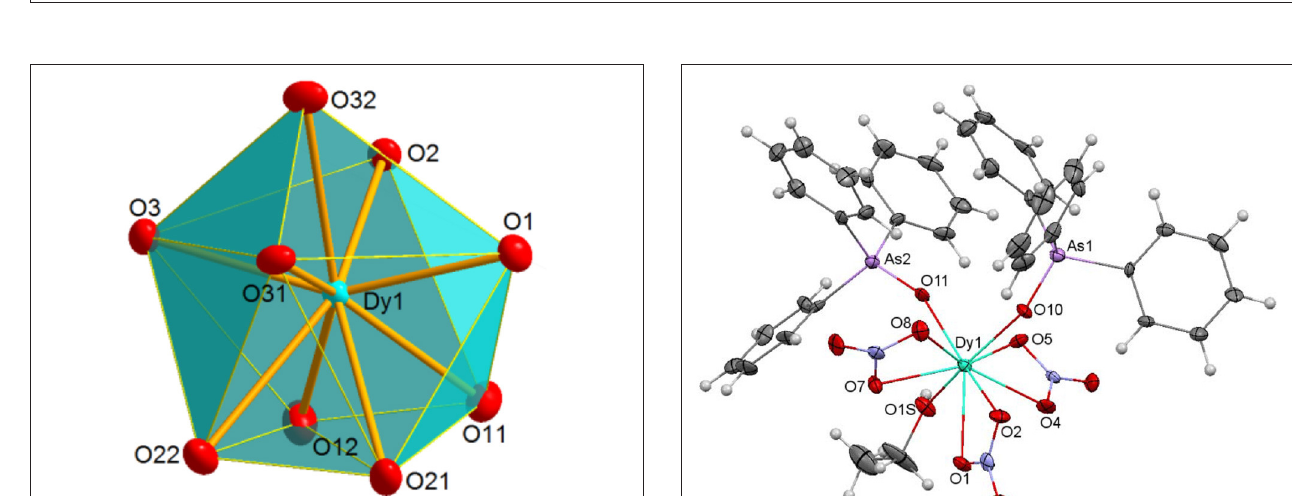
FIGURE 2 | Ellipsoids diagram (50% probability) for 1. Only the Tb, P, and donor O-atoms have been labeled, for clarity. Color code: Tb, light blue; C, gray; H, light gray; N, dark blue; P, orange; O, red.